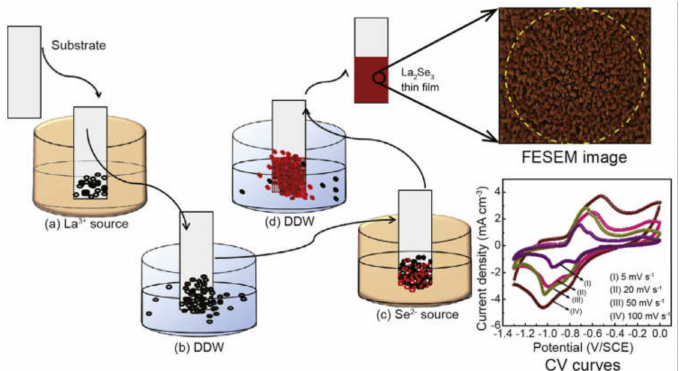
Figure 12. Stepwise synthesis procedure of La 2 Se 3 via the SILAR method and its FESEM image and CV curves. Reproduced with permission from [197]. Elsevier,